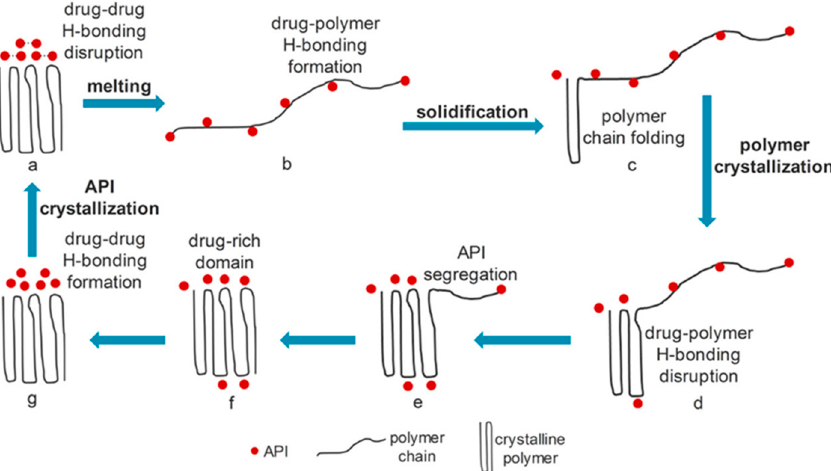
Figure 7. Reprinted with permission from T. Van Duong et al., “Spectroscopic Investigation of the Formation and Disruption of Hydrogen Bonds in Pharmaceutical Semicrystalline Dispersions,” Mol.